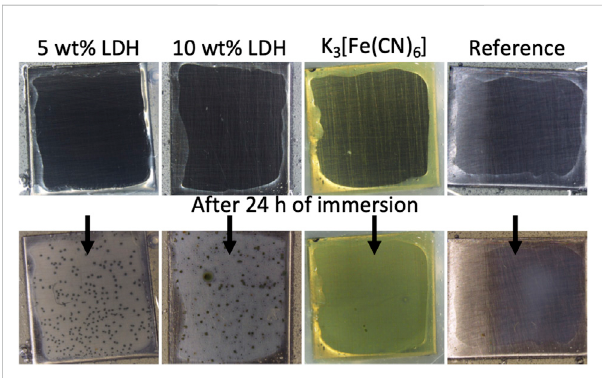
FIGURE 4 Visualanalysisofthesurfaceofthecoatedsteelplatesbeforeand after immersion in 0.05 M NaCl solution for 24